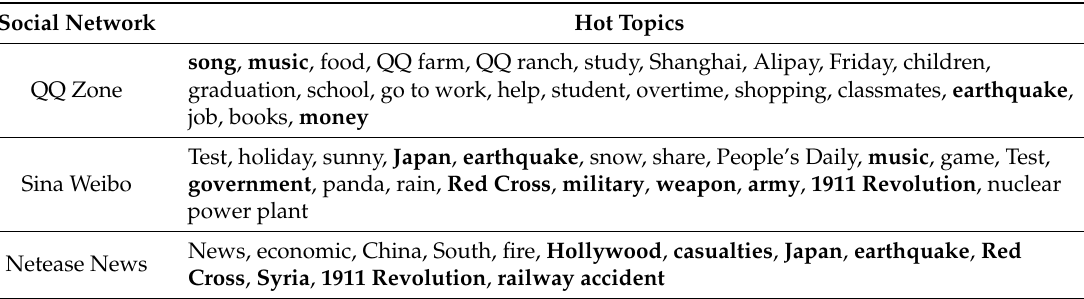
Table 5. Hot topics from each social